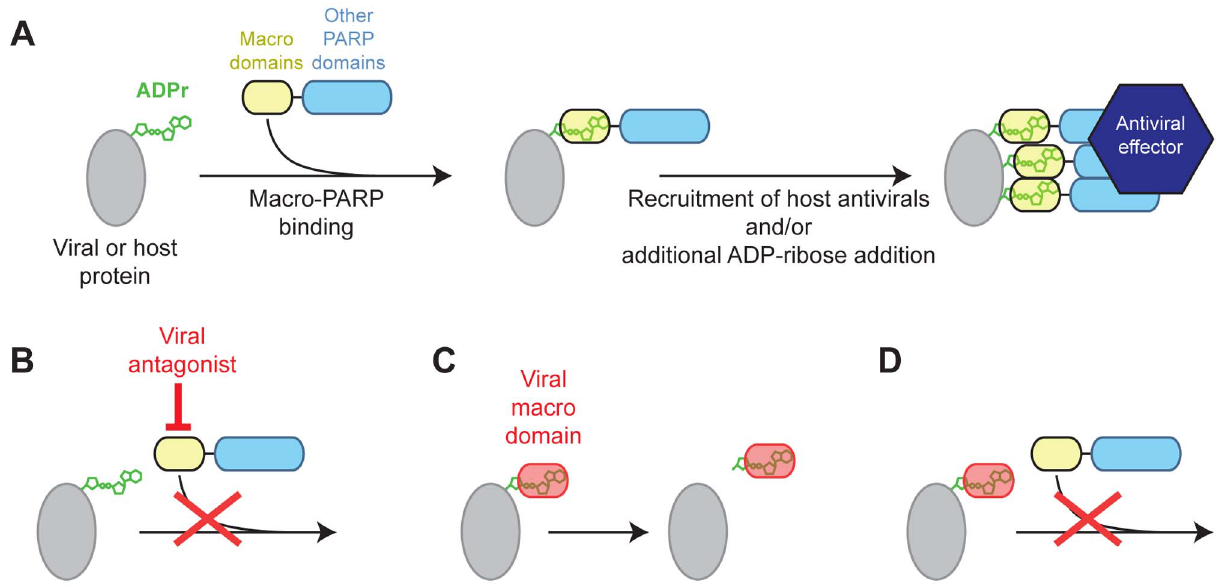
Figure 5. Model for genetic conflict involving PARP macrodomains. (A) Model for macro-PARP function. ADP-ribosylated host or viral proteins may be a signal for recruitment of PARP9, 14 or 15, which could facilitate additional recruitment of antiviral effectors, and amplify the initial ADPr signal. (B–D) Three models for how viruses may antagonize macro-PARP function. Viruses lacking their own macrodomains may use other proteins to directly antagonize macro-PARP proteins (B), driving recurrent positive selection in macro-PARP genes to escape antagonism. Macrodomains encoded by viruses (e.g. corona- and togaviruses) may catalyze the removal of ADPr (C) or compete with macro-PARPs for binding to ADPr (D) in order to antagonize host ADPr-mediated signaling.